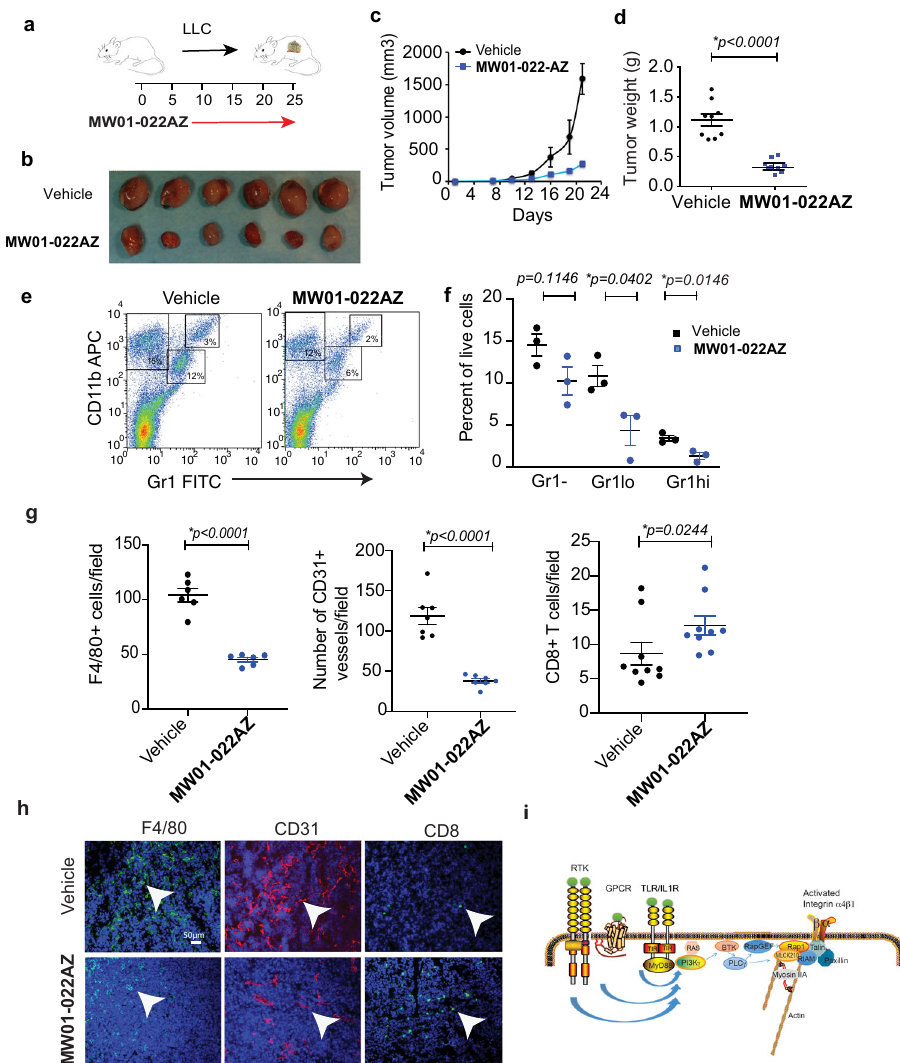
Fig. 9 Pharmacological inhibitor of MLCK MW01-022AZ suppressed tumor in fl ammation and growth. a Schematic of LLC lung tumor implantation in C57Bl6 mice and MW01-022AZ treatment. b – d Effect of MW01-022AZ on LLC b gross tumor morphology ( n = tumors from 6 mice) c tumor volume ( n = 9 mice and d tumor weight at endpoint (21 days) ( n = 9 mice). *p < 0.0001 for vehicle vs MW01-022AZ treatment, determined by t -test. e FACS pro fi les and f quanti fi cation of Gr1-CD11b + ( p = 0.1146) Gr1loCD11b + (* p = 0.0402), Gr1hiCD11b + (* p = 0.0146) myeloid cells in representative MW01- 022AZ vs vehicle-treated tumors at endpoint (21 days) ( n = 3 mice), determined by t -test. For Facs gating scheme, see Supplementary Fig. 7b. g Quanti fi cation and h representative histographs of F4/80 + macrophages ( n = sections from 6 mice) *p < 0.0001 for vehicle or MW01-022AZ by t -test, CD31 + blood vessels ( n = sections from 7 mice) *p < 0.0001 for vehicle or MW01-022AZ by t -test, CD8 + T cells ( n = sections from 9 mice) *p = 0.0244 for vehicle vs MW01-022AZ by Mann – Whitney test in tissues from mice treated with vehicle or MW01-022AZ . i Model of integrin activation demonstrating that cytokine stimulation activates a pathway whereby PI3K γ induces MLCK210 and myosin activation and colocalization with Rap1, resulting in Rap1-mediated integrin α 4 conformation changes and interaction of the integrin with the actin cytoskeleton. Data are presented as mean values ± SEM. Statistical signi fi cance determined by Student ’ s t -test. Experiments were performed twice. Source data are provided with this article as a Source Data fi